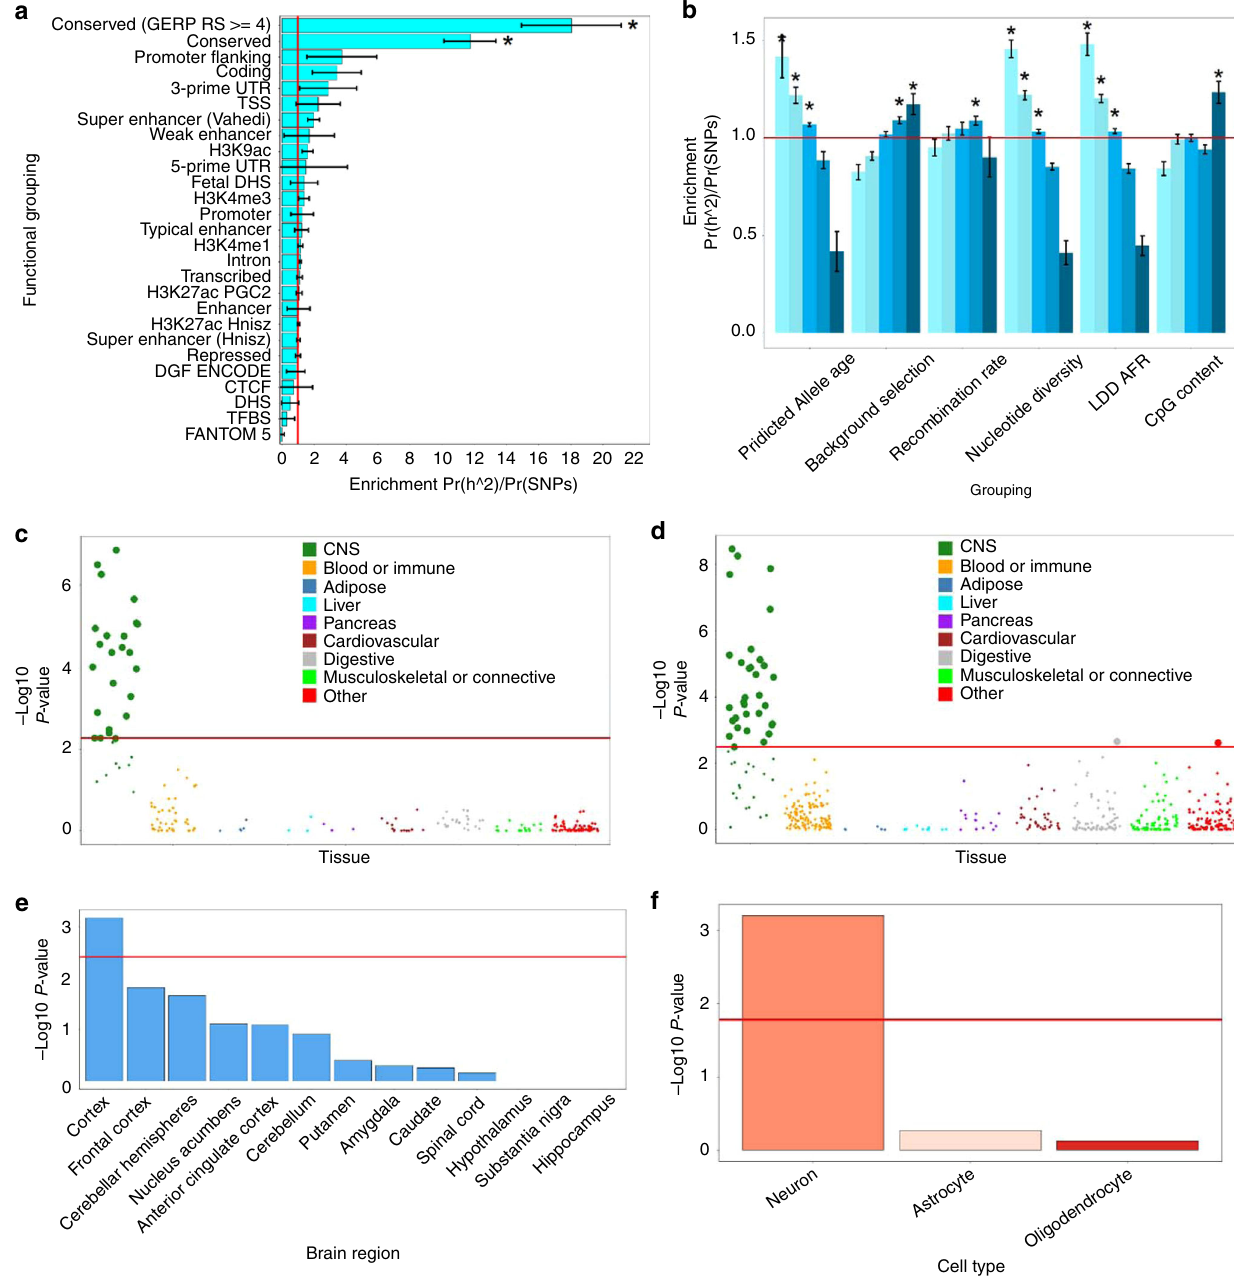
Fig. 5 Partitioned heritability of income. a Enrichment analysis for income using the 60 functional categories as well as 10 minor allele frequency groupings and 6 continuous annotations (27 categories describing enrichment within these categories is shown). This analysis differs from that presented in Figs. 3 and 4 as here all SNPs are used, not only those that reached genome-wide signi fi cance (Fig. 3) or SNPs that were located within protein-coding genes (Fig. 4). The enrichment statistic is the proportion of heritability found in each functional group divided by the proportion of SNPS in each group (Pr ( h 2 )/Pr(SNPs)). The red line indicates no enrichment found when Pr( h 2 )/Pr(SNPs) = 1. Error bars represent ± 1 SE. A Bonferroni correction controlling for 57 tests was used to ascertain statistical signi fi cance that is indicated by an asterisk. b Enrichment analysis for the six continuous annotations by quintile. Shading represents quintile with light colours corresponding to low quintiles and dark colours to high quintiles. Groupings that contained a signi fi cantly greater proportion of heritability proportional to the number of SNPs they contain are marked with an asterisk. Multiple testing was performed within each of the annotations resulting in an α level of α = 0.05/5 = 0.01, with a red line indicating no enrichment. Error bars represent ± 1 SE. c , d shows the enrichment of 205 tissues of cell types assembled using gene expression data and 489 groupings assembled using chromatin data. In each instance, these were arranged into nine tissue-type groupings with correction for multiple testing been performed using false discovery rate (FDR) 83 conducted separately for the gene expression and the chromatin groupings indicated by a red line. e Shows if the genes that were expressed in 13 brain regions are enriched for the heritability of income. A Bonferroni correction was used to control for 13 tests and the α level was set at 0.004 with the brain regions that crossed the red line being those that were statistically signi fi cant. f shows the level of enrichment for three brain cell types. A Bonferroni correction was used to control for three tests ( α = 0.05/3 = 0.017) and groupings that crossed the red line were those that were statistically signi fi cant. The full results for each of these analyses can be found in Supplementary Data 9, Supplementary Table 5, Supplementary Data 10 and 11 and Supplementary Tables 6 and